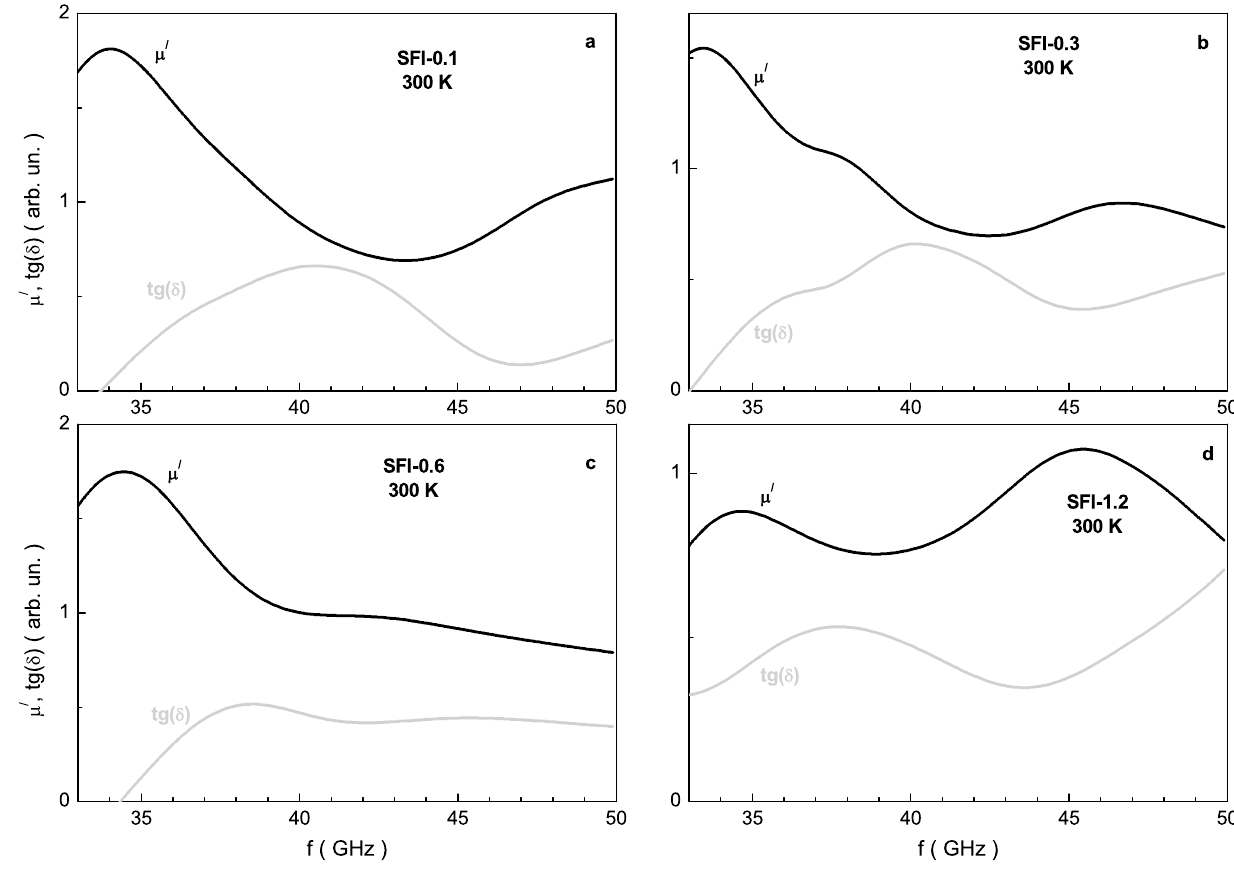
Figure 8. Graph of the μ / real part of permeability (black line) and tg(δ) loss tangent (grey line) vs. frequency at room temperature for the SFI-x samples with x = 0.1 ( a ), 0.3 ( b ), 0.6 ( c ) and 1.2 ( d